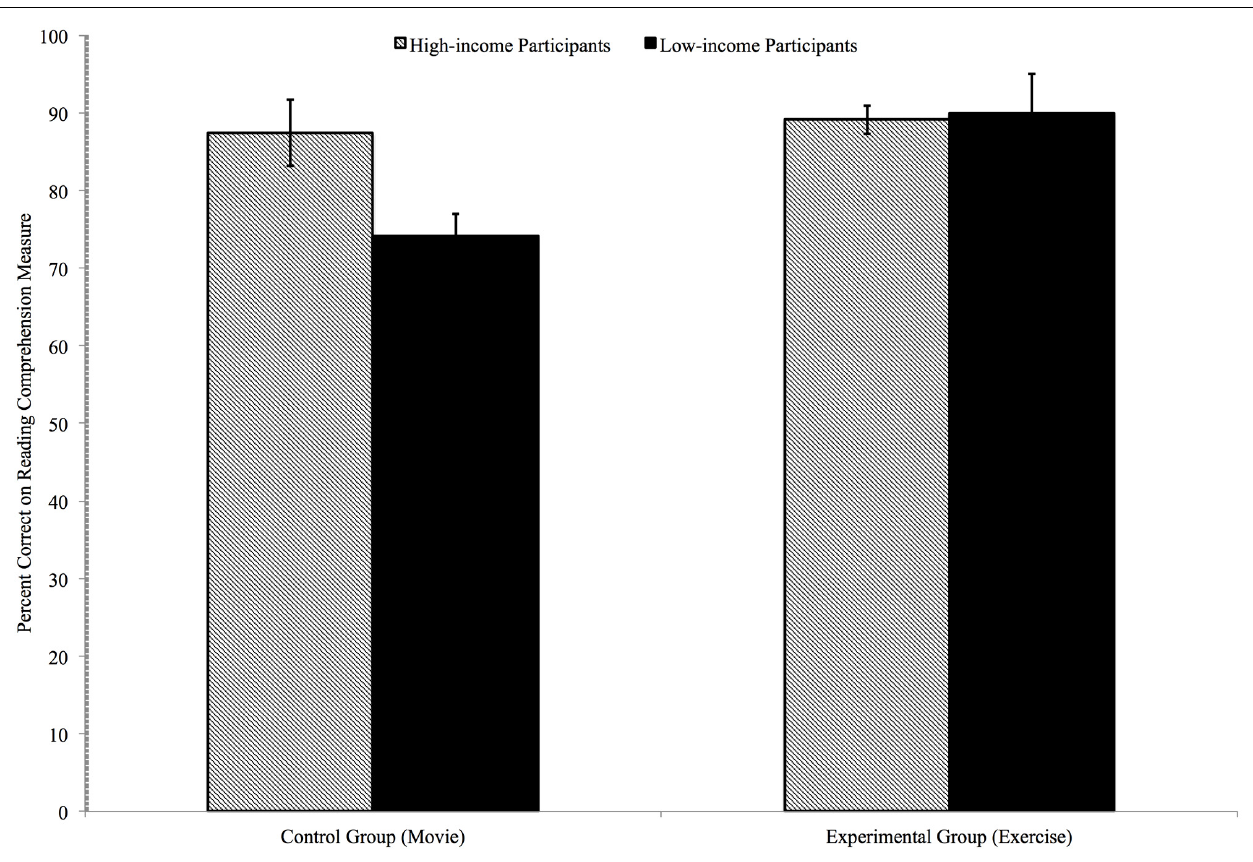
FIGURE 2 | Reading comprehension as a function of exercise and income